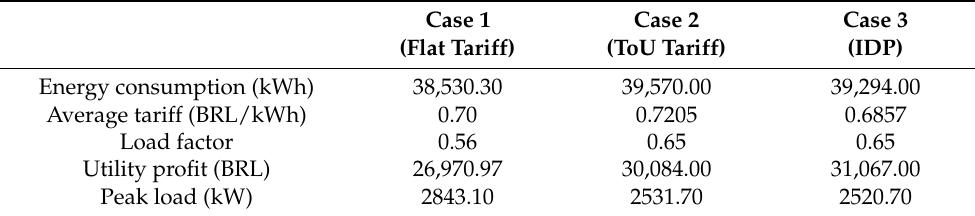
Table 4. Simulations Results with Renewable Energy.